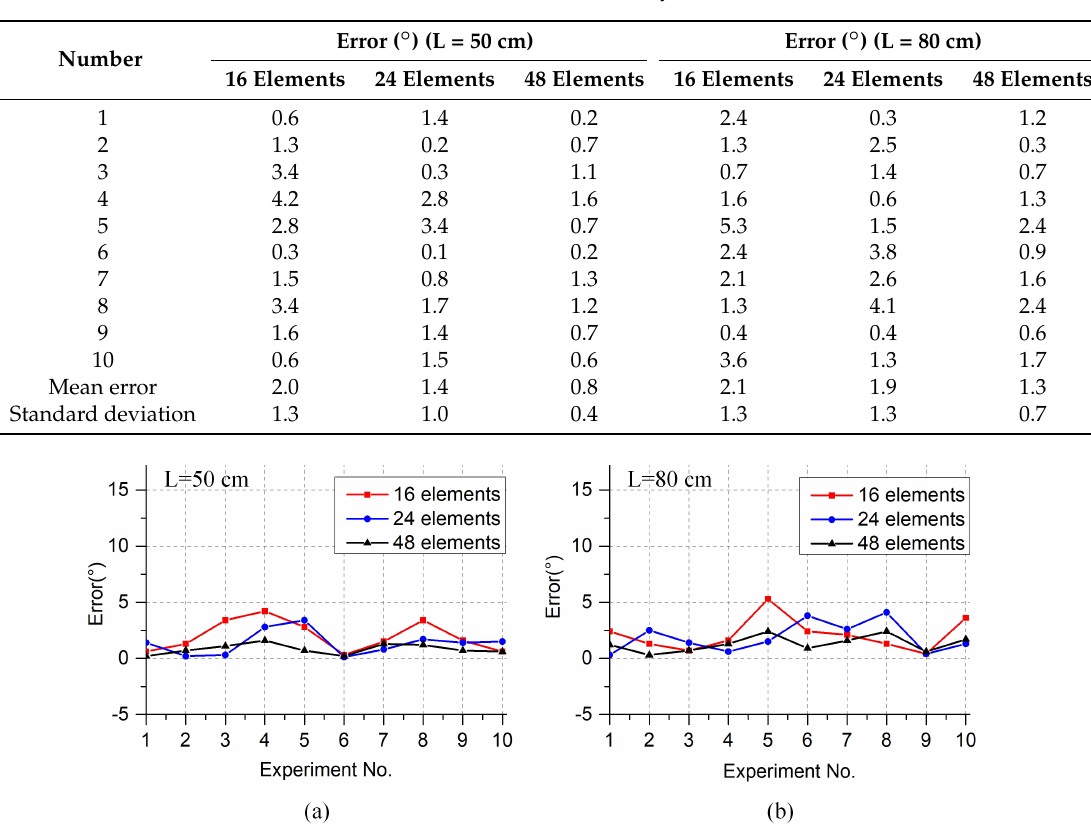
Figure 7. ( a ) The results of different numbers of array elements. ( b ) The results of different distances. Table 3. Localization error with different numbers of array elements and different distances.